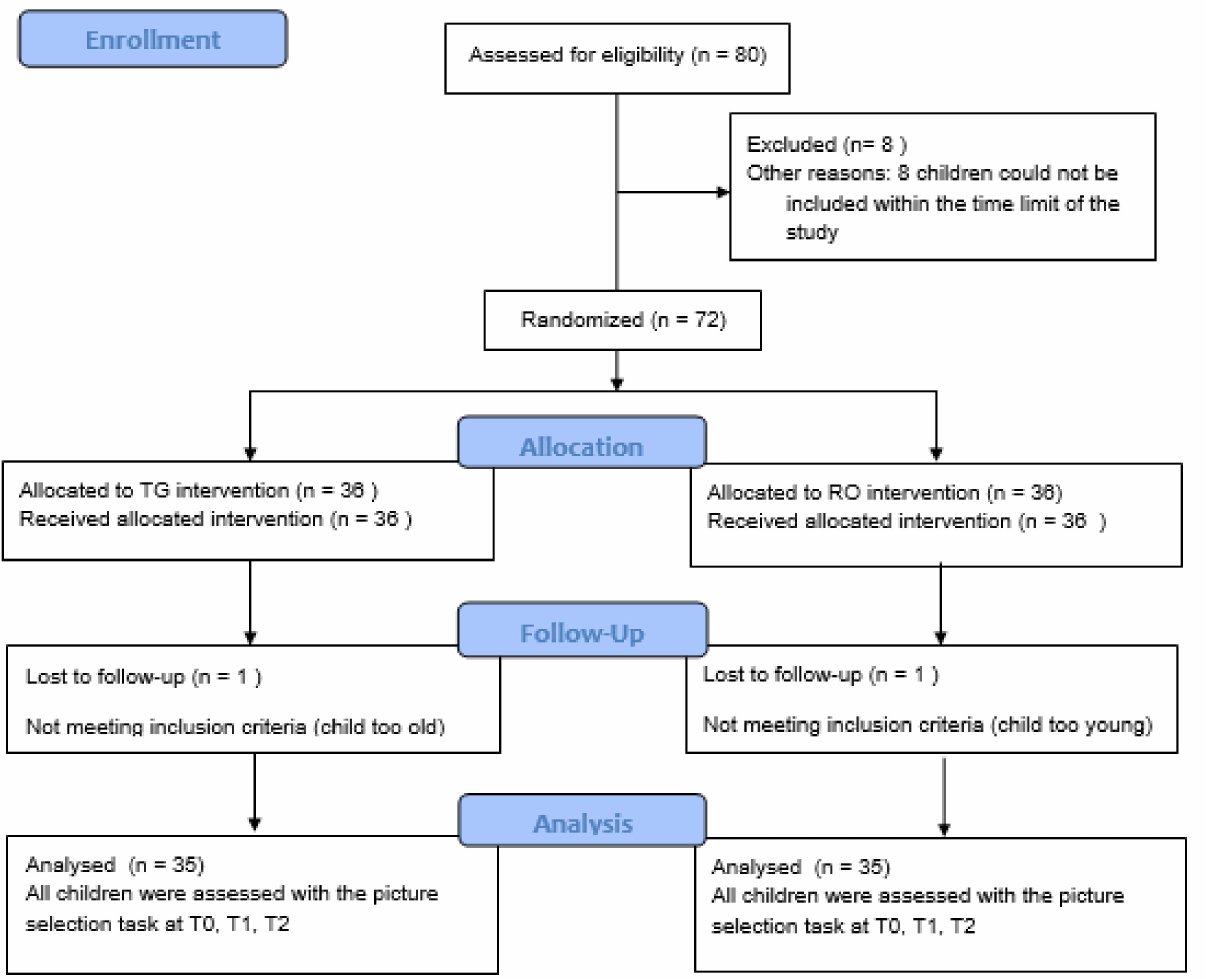
Figure 1. Consolidated Standards of Reporting Trials diagram. TG = tablet game condition; RO = real objects